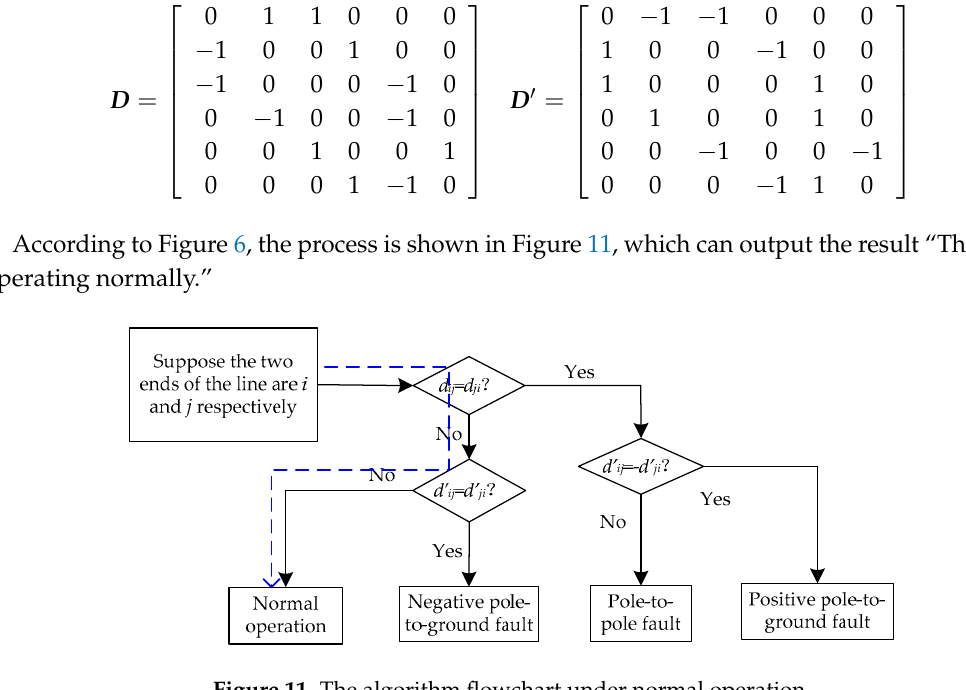
Figure 11. The algorithm flowchart under normal operation.